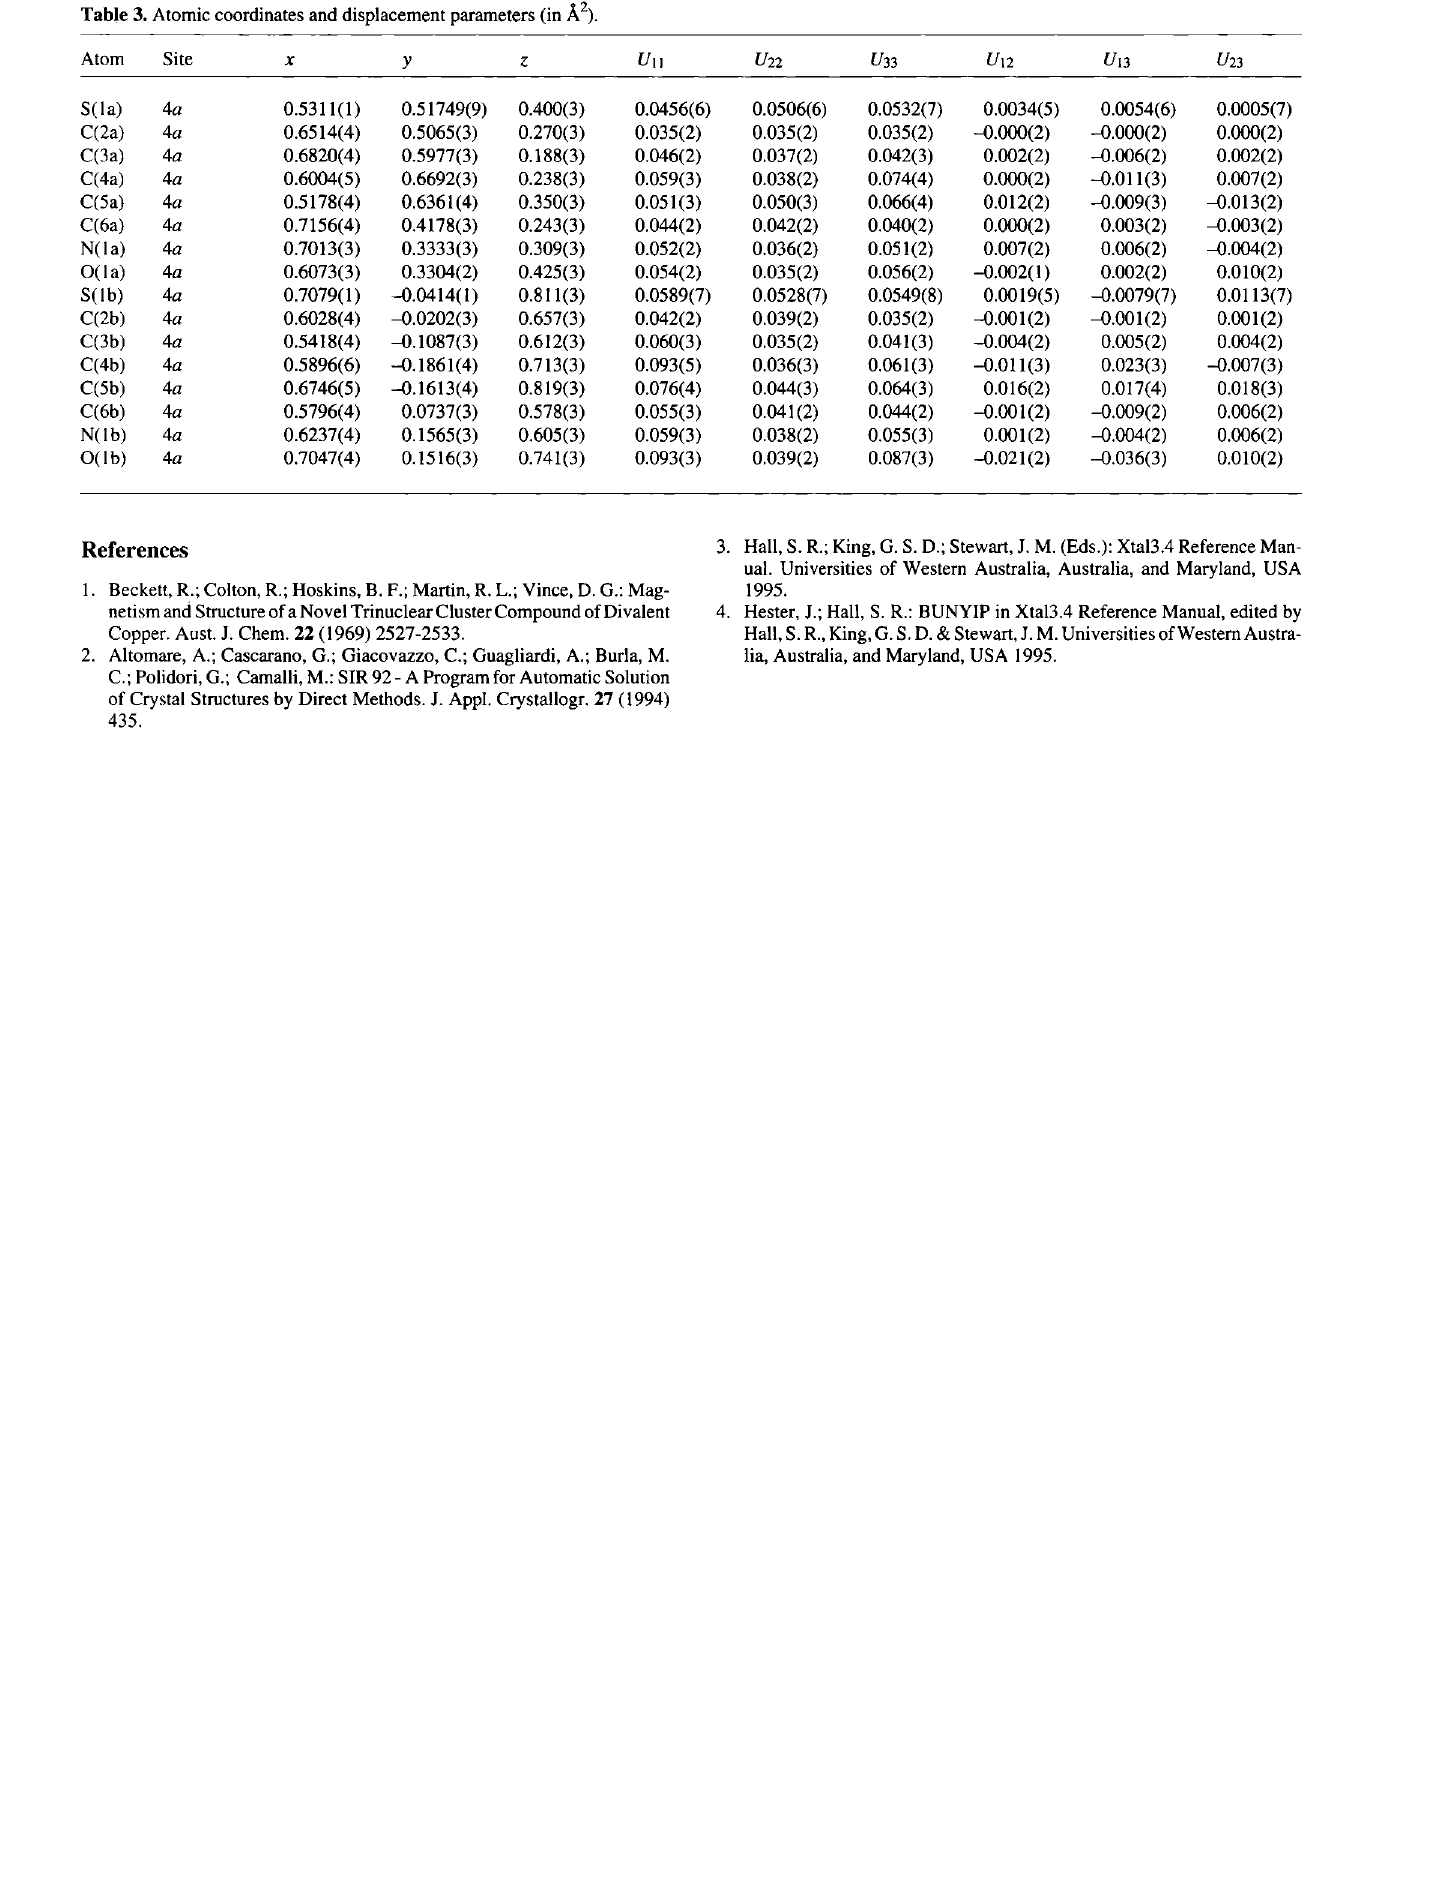
Table 3. Atomic coordinates and displacement parameters (in Ä 2